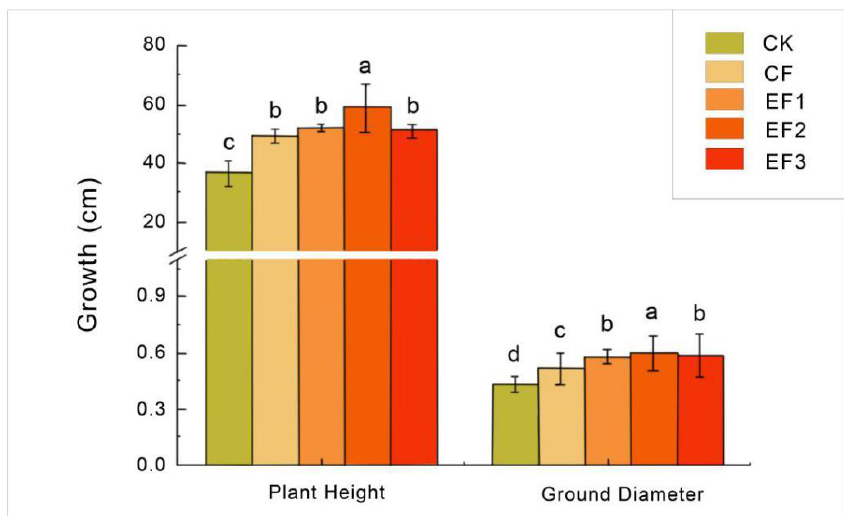
Figure 2. Plant height and ground diameter of Chinese fir cuttings at different fertilization levels. Different letters indicate significant differences between treatments ( p < 0.05). CK: Control; CF: Conventional Fertilization; EF1: Exponential Fertilization 1 (0.5 nitrogen (N) g cuttling −1 ); EF2: Exponential Fertilization 2 (1.0 N g cutting −1 ); EF3: Exponential Fertilization 3 (2.0 N g cutting −1 ).